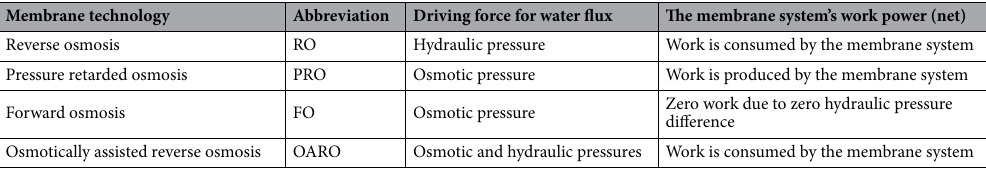
Table 1. Membrane system classification, based on the driving